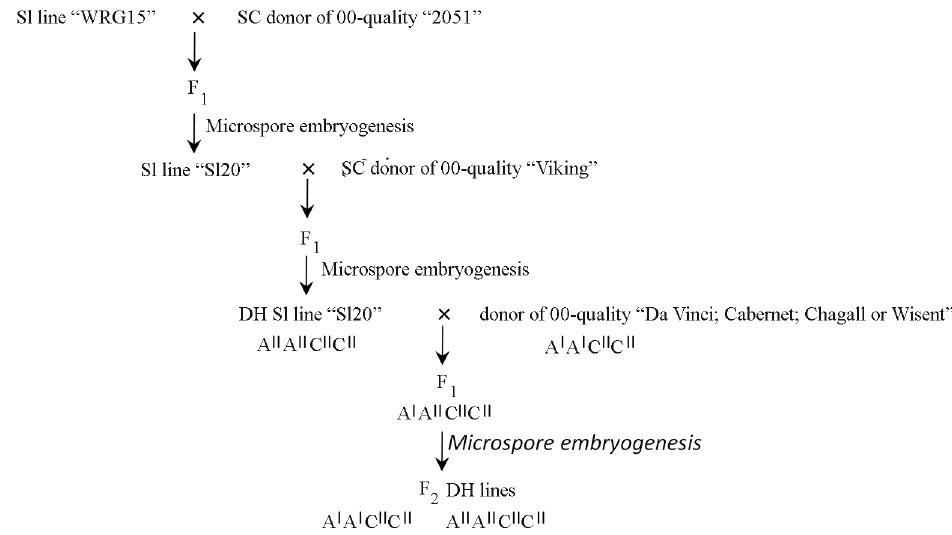
Figure 1 - Overview of the triple-cross model, including the three-component hybrid and three line hybrid in B. napus